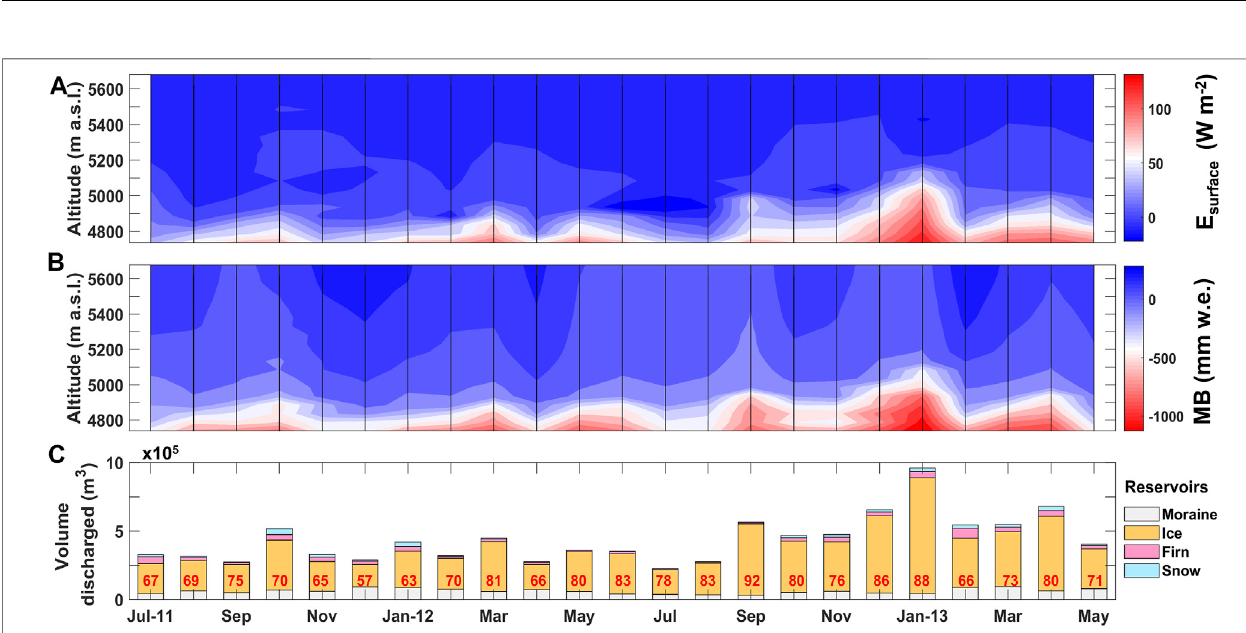
FIGURE 11 | (A) Monthly pro fi le of surface energy available at surface. (B) Monthly mass balance pro fi le. (C) Monthly discharge cumulated at each reservoir. Numbers in red represents the ice reservoir contribution concerning total discharge.